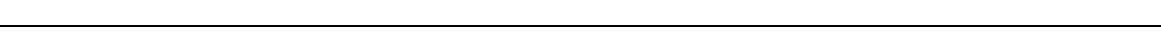
Fig. 3 Hydrogen peroxide treatment of wild-type yeast cells. a Carbonylation of proteins in wild-type cells treated with 1 mM H 2 O 2 for 30 min was analysed by immunoblotting with anti-DNP antibody or quanti fi ed by spectrophotometry. Mean ± SEM, n = 3, * P- value < 0.05; two-sided, paired t -test DNP(H), 2,4- dinitrophenyl(hydrazine). b Volcano plot showing H 2 O 2 -dependent changes in protein abundance. In total, 3,116 unique proteins and 61 protein groups were quanti fi ed. Shaded areas highlight proteins with an average fold change of ≥ 2 (average log 10 ratio = ± 0.3) and a P- value < 0.05 ( − log 10 P- value > 1.3; n = 3, two-sided t -test). Dark grey, regulated proteins with the GO term ‘ response to oxidative stress ’ and/or ‘ oxidoreductase activity ’ . c Wild-type cells were grown in fermentative medium at 28 °C and when indicated treated with 1 mM H 2 O 2 for 30 min. Samples were analysed by immunoblotting. *Unspeci fi c band. d Left: volcano plot showing difference in average % oxidation (H 2 O 2 -treated minus untreated samples) for 4,341 unique cysteine- containing peptides plotted against − log 10 P- value highlighting unique cysteine-containing peptides with signi fi cantly increased oxidation levels (dark grey, P- value < 0.05, n = 3, ANOVA). Lines indicate difference in average % oxidation > 7 and a P- value of 0.05 ( − log = 1.3). Right: zoom-in of the region 10 highlighted in the volcano plot. Peptides of proteins annotated with the GO term ‘ ribonucleoprotein complex ’ are highlighted (dark grey). e GO term enrichment analysis of proteins with signi fi cantly increased oxidation levels. P- values after Benjamini – Hochberg FDR ( < 0.05) correction were plotted against their corresponding GO terms from the three main domains (cellular component, molecular function and biological process). For each GO term, the number of proteins is